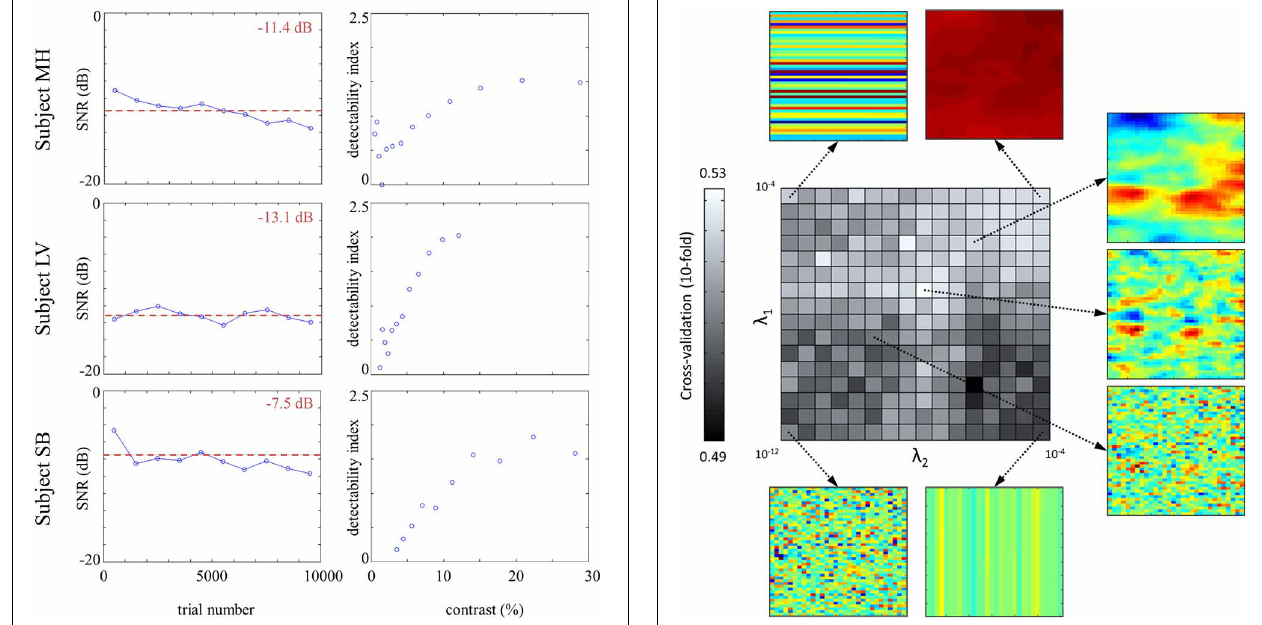
FIGURE 2 | (A) Evolution of SNR across trials (mean SNR by blocks of 1000 trials) for each participant, and overall mean SNR (red dotted line). (B) Psychometric function of each participant: detectability index d (cid:2) (defined as (cid:2) (cid:3) (cid:2) (cid:3) − (cid:2) − 1 d (cid:2) = (cid:2) − 1 P H P FA as a function of signal contrast (values calculated on less than 20 observations are not included).